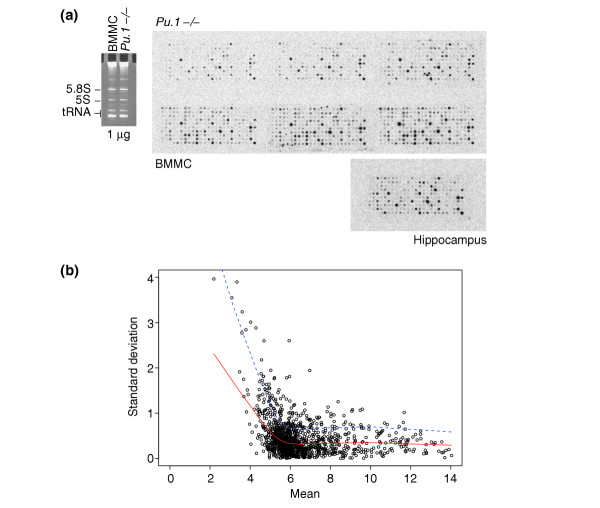
Design and reproducibility of microarrays. (a) Examples of microarrays: three membranes were used for each biological sample; arrays for Pu.1-/- cells, BMMC and hippocampus are shown. On the left, ethidium bromide staining of total RNA run on a denaturing gel for RNA quantification and quality control. (b) Plot of the standard deviation over replicates versus the mean of each replicate. The red line is a lowest fit to the distribution and the blue dotted line is twice the value of the red one. Points below the blue curve are considered good replicates; those above it are filtered out as too noisy. For this dataset, 86% of the spots were considered as good. BMMC, bone marrow-derived mast cells.